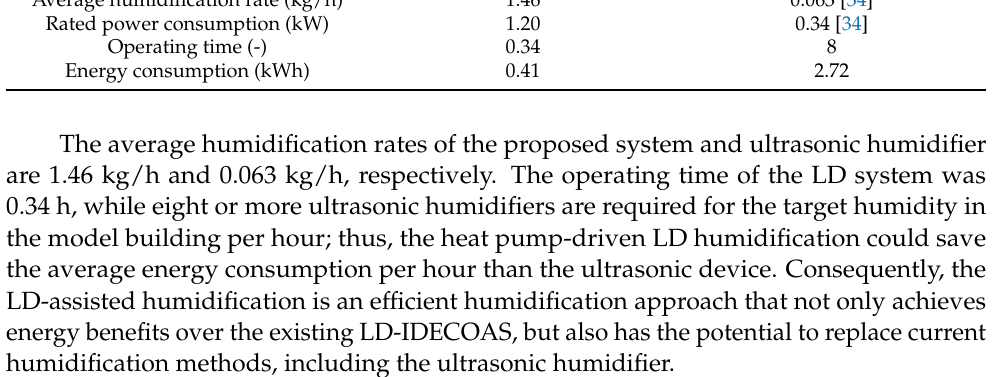
Table 8. The performance of each humidification approach.